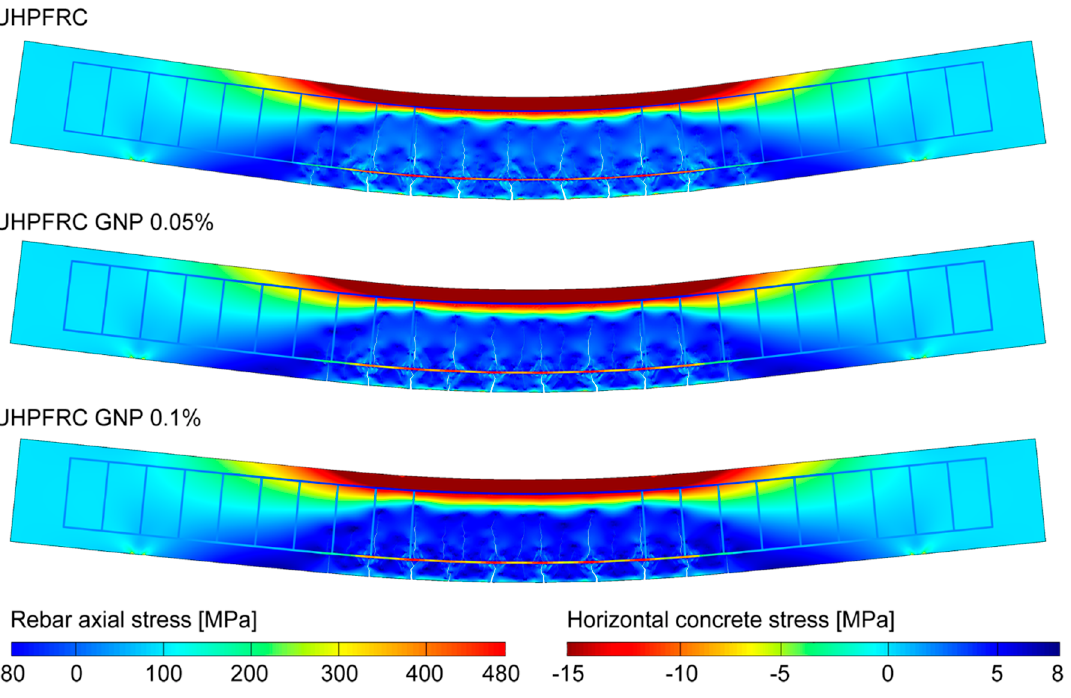
Figure 9. Deformed configurations (magnified by a multiplicative factor equal to 15) and stress maps for the three simulated steel bar-reinforced GNP-enhanced UHFRC beams at a load level of 65 kN.